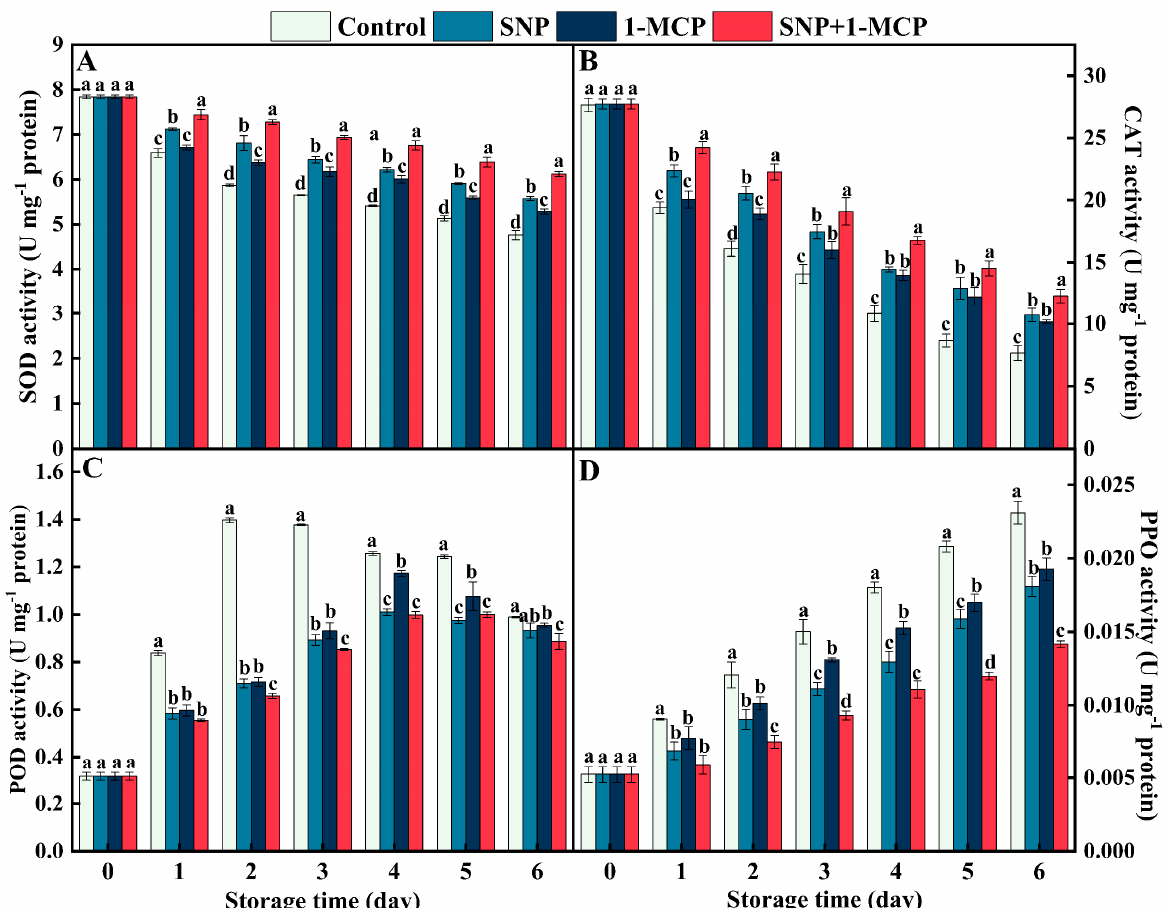
Figure 3. ( A ) Superoxide dismutase (SOD), ( B ) catalase (CAT), ( C ) peroxidase (POD), and ( D ) polyphenol oxidase (PPO) activities of Agaricus bisporus at 25 °C. The letters indicate the significant difference ( p < 0.05), and the bars indicate standard error (means ± SE).